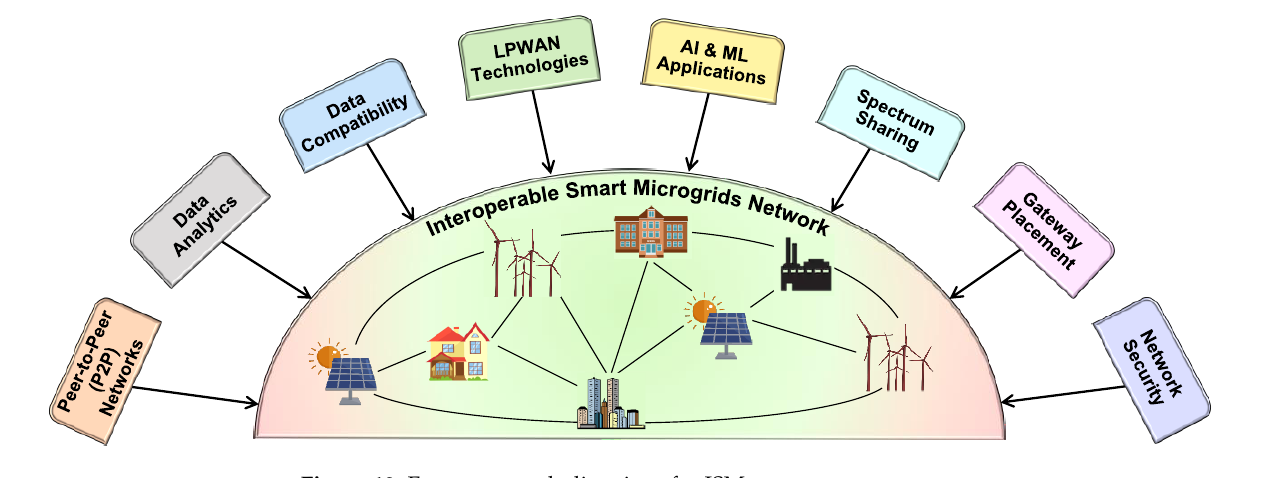
Figure 10. Future research directions for ISMs.